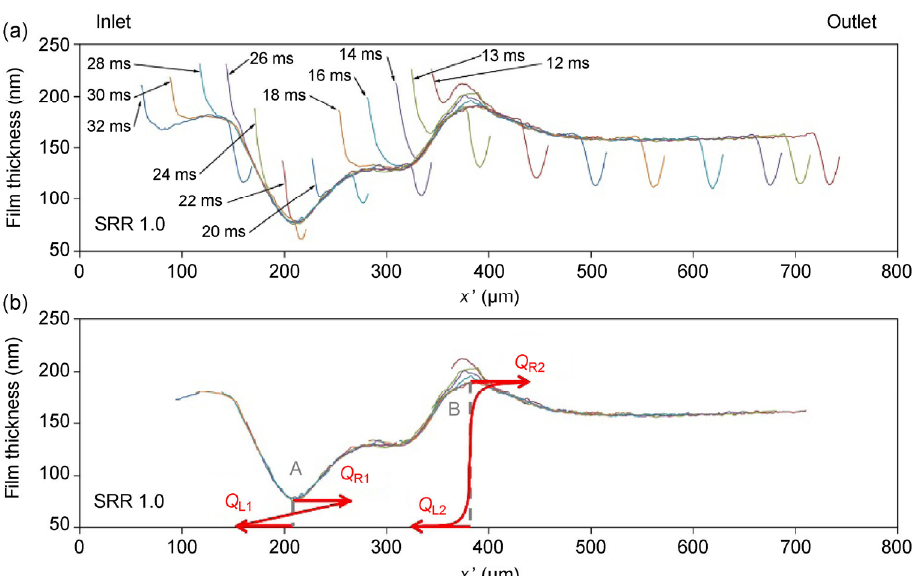
Fig. 10 Centerline film thickness profiles plotted against modified x ’ coordinate: (a) complete profiles; (b) parts of profiles in central